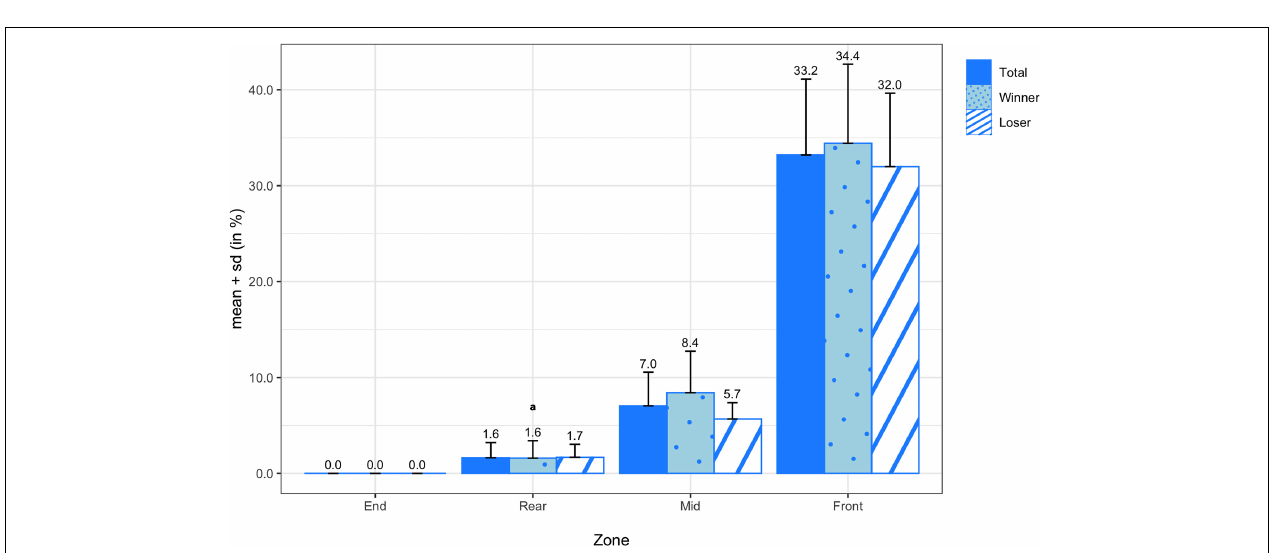
FIGURE 8 | Transition probabilities of points scored by zone for all teams, winning teams, and losing teams. Variables compared using a non-parametric test are marked with an a .